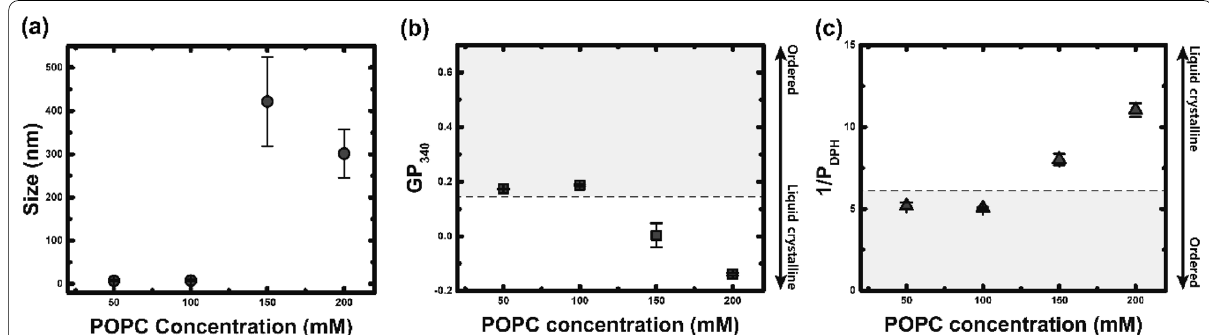
Fig. 4 a Size, b membrane polarity, c membrane fluidity of synthesized assemblies depending on POPC concentration with 20 mM DHPC. Synthesis of lipid assemblies was performed at 20 °C using the microfluidic chip. The values and error bar indicate the mean values and standard deviation of measured data, respectively. The borderline of the membrane rigidity was adjusted, based on the membrane properties of homogeneous POPC